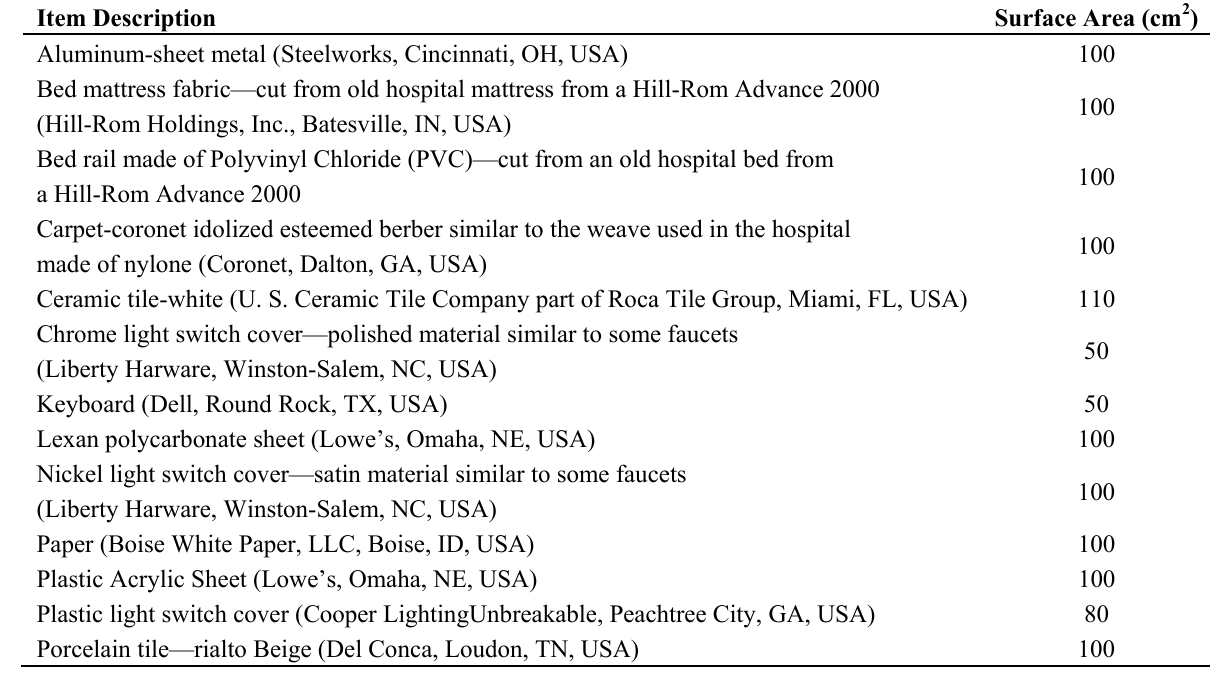
Table 1. Healthcare related surfaces (coupons) that were